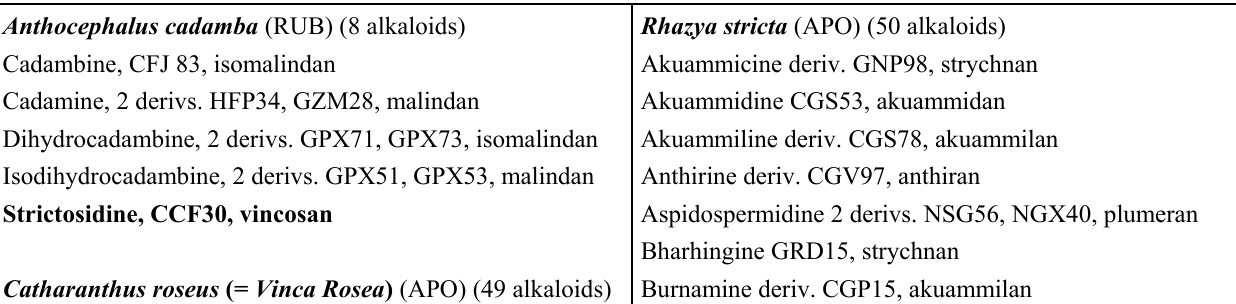
Table 1. Coalkaloids of Strictosidine (parent name, number of derivatives, C&H number, type of